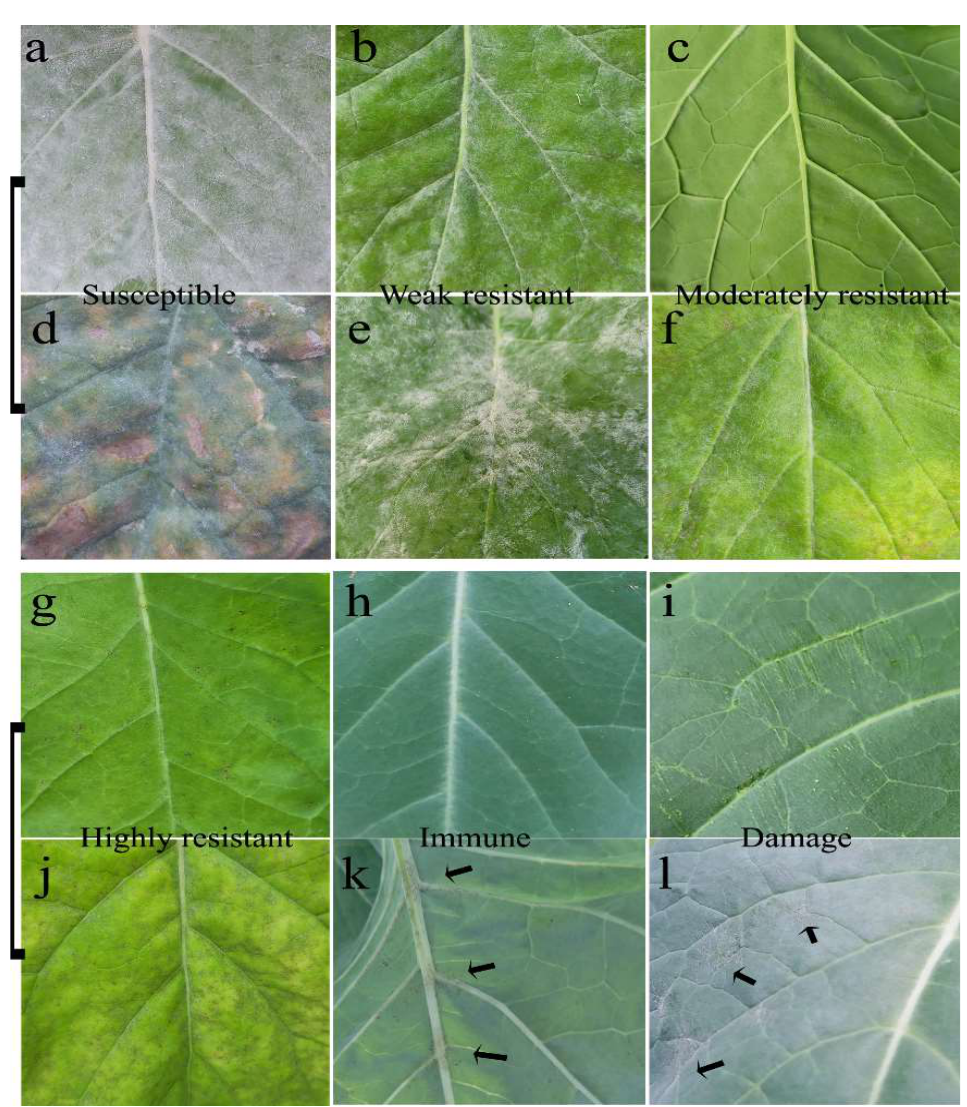
Figure 1. Phenotypic differences in the leaves of the different plant accessions after PM inoculation. More hyphae and mycelia were produced on the susceptible cultivar ‘ZS11’ ( a ) and the weakly resistant plant ( b ) than the moderately resistant plant in the BC 1 F 3 population ( c ) and the highly resistant ‘BCWF’ ( g ). Necrotic lesions on the older leaves ( d – f , j ) of the above-mentioned plants. No hypha was found on the leaves of immune plant ‘WF’ ( h ), but we observed some brown dots on the older leaf of ‘WF’ ( k , arrowheads). The spores could not penetrate the leaf of ‘WF’, where surface injury was caused by sandpaper friction ( i ), but mild infection ( l , arrowheads) was observed on unhealthy plants with lateral root